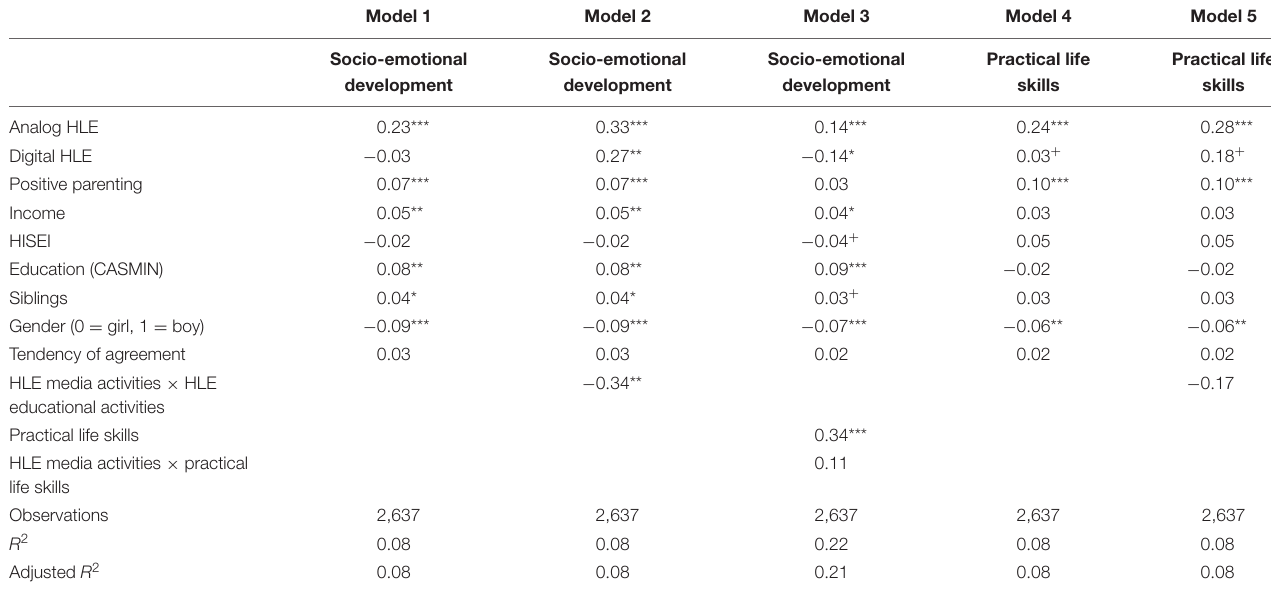
TABLE 6 | Multivariate regressions: associations between toddler’s socio-emotional outcomes, practical life skills, and digital and analog HLEs.